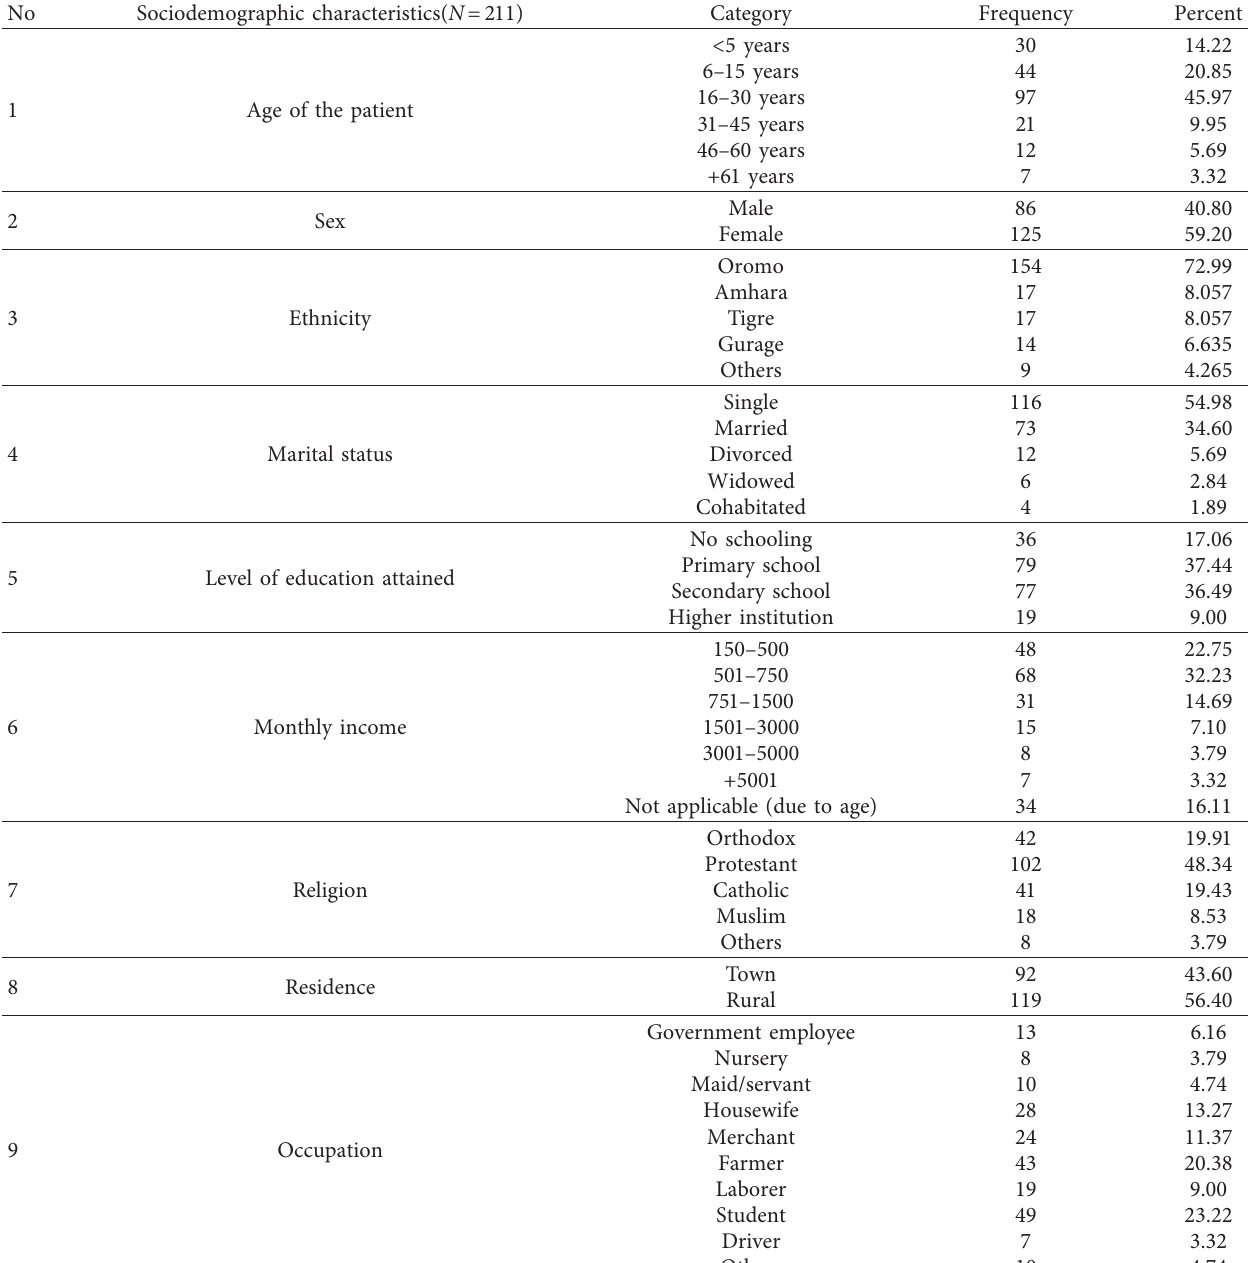
Table 1: Sociodemographic characteristics of the study participants in western Ethiopia,